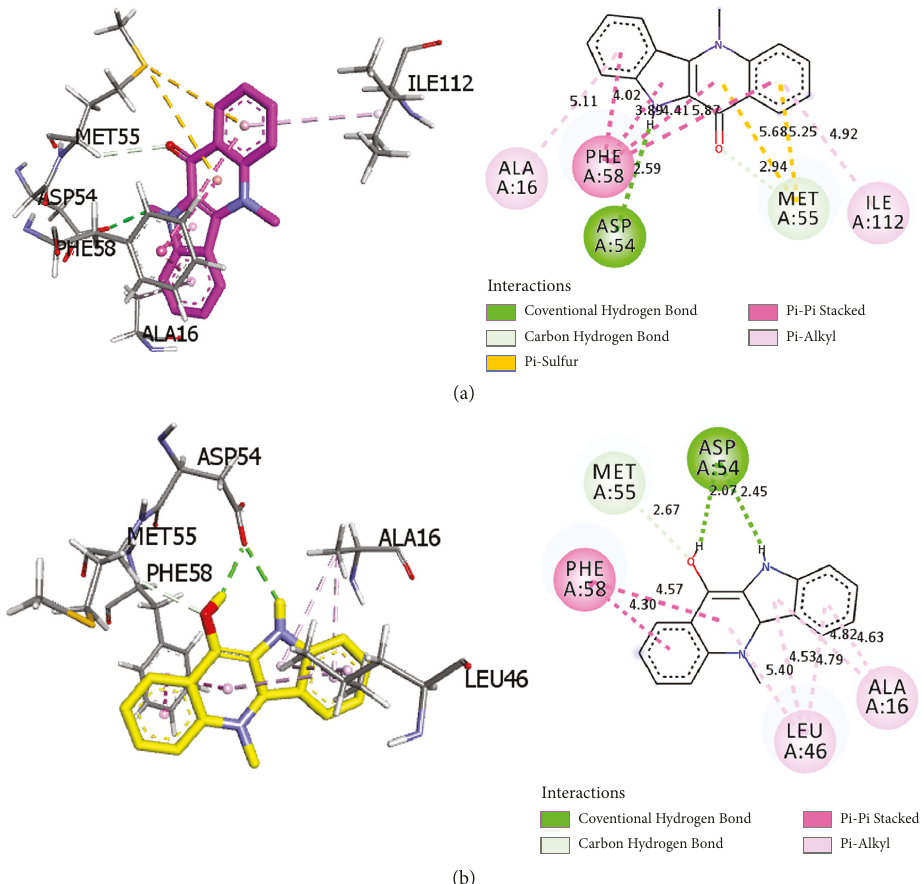
Figure 6: Interactions of some alkaloids with dm- Pf DHFR: 3D (left) and 2D (right) views of interactions of (a) cryptolepinone and (b) hydroxycryptolepine with residues in the binding region of double mutant Pf DHFR (1J3J). Description of interactions is provided under 2D